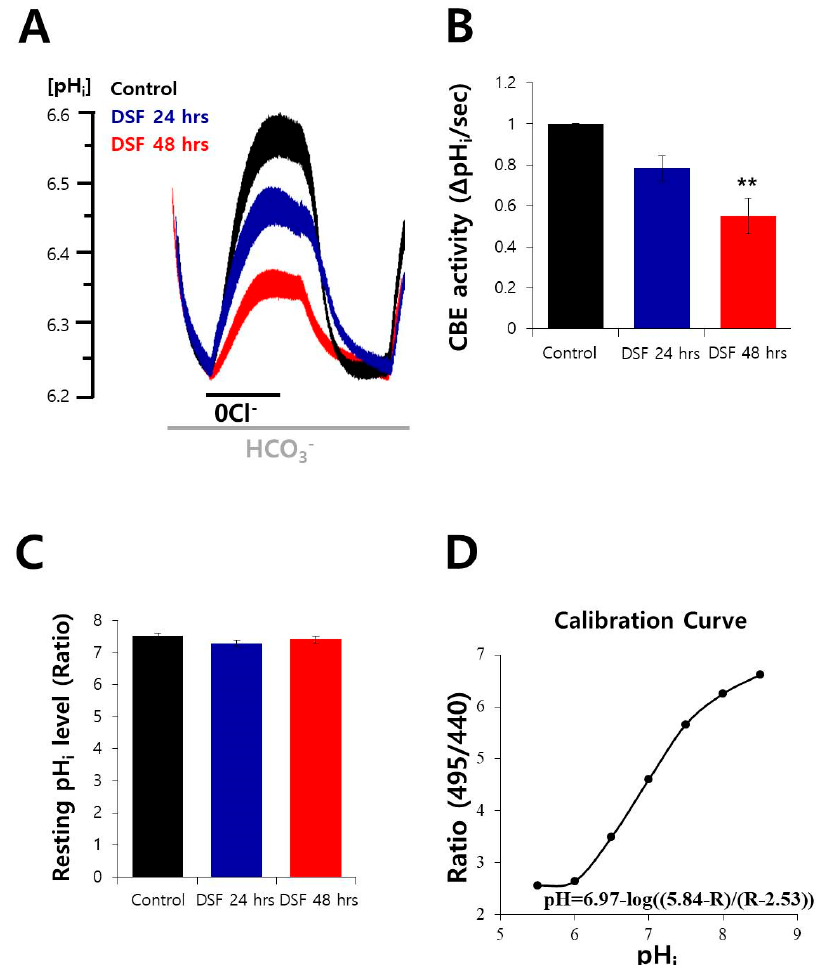
Figure 3. DSF decreased CBE activity in A549 cells. ( A ) CBE activity of A549 cells with and without treatment with 2 µ M DSF (blue trace at 24 h, red trace at 48 h, and control, black trace). Average traces are represented. ( B ) Bars indicate the means ± SEM (n = 4, ** p < 0.01). ( C ) The bars show resting intracellular pH (pH i ) level of A549 cells represented as the means ± SEM. ( D ) The calibration curve of A549 cells (pH = 6.97-log(5.84-R/R-2.53)).